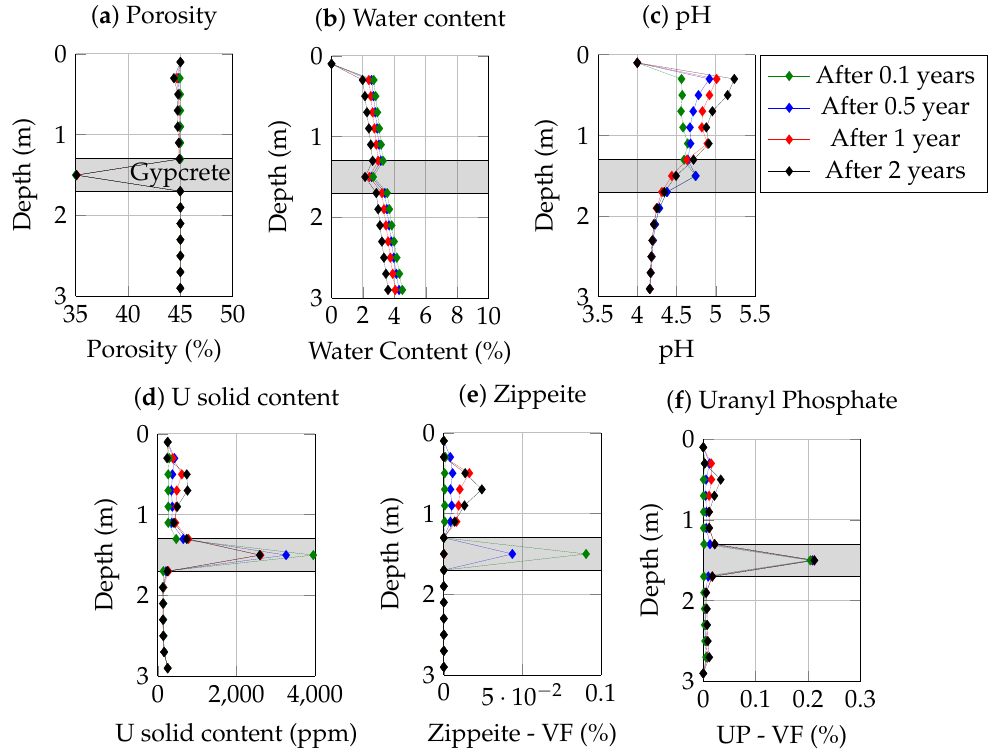
Figure 8. Profile evolution of the tailings after being buried. The shaded gray area corresponds to the paleocrust. ( a ) Porosity evolution, ( b ) water content, ( c ) pH, ( d ) U content in the solid phase, ( e ) zippeite and ( f ) uranyl